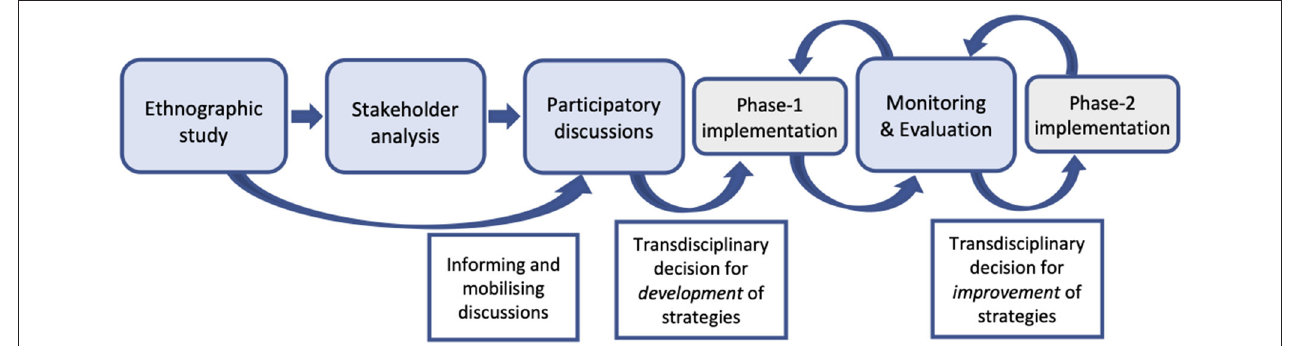
FIGURE 2 | Analysis and reflection of findings to iterative